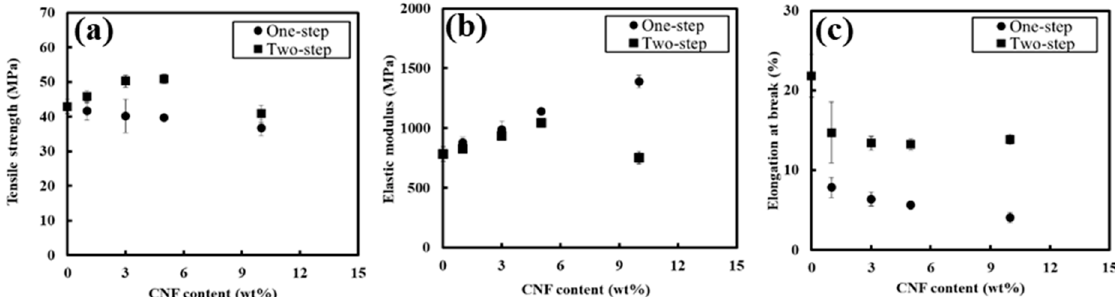
Figure 4. Tensile strength ( a ), elastic modulus ( b ), and elongation at break ( c ) of PBS/PCNF with different PCNF contents and processing.